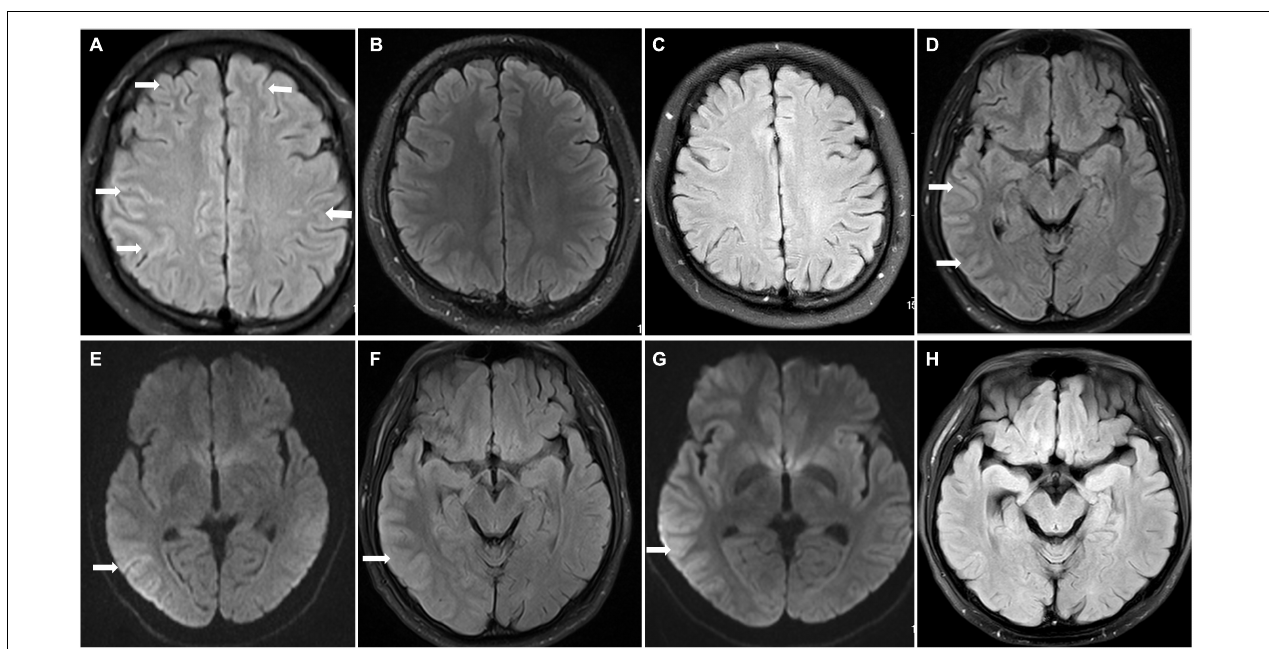
FIGURE 1 | Brain magnetic resonance imaging (MRI) findings in patients 1 and 2. Patient 1 (A–C) On admission, FLAIR hyperintensity was seen in the leptomeningeal of bilateral frontal lobe and parietal lobe in patient 1 (A) (arrowhead); repeat brain MRI FLAIR result returned to normal at discharge and 8 months after discharge (B,C) . Patient 2 (D–G) Brain MRI results showed T2 FLAIR and DWI hyperintensity (D,E) (arrowhead) with swelling of brain tissue and narrowing of sulcus; the swelling of brain tissue was alleviated, and hyperintensity of FLAIR and DWI was improved after immunotherapy (F,G) (arrowhead); brain MRI normalized at 1 month after discharge (H)